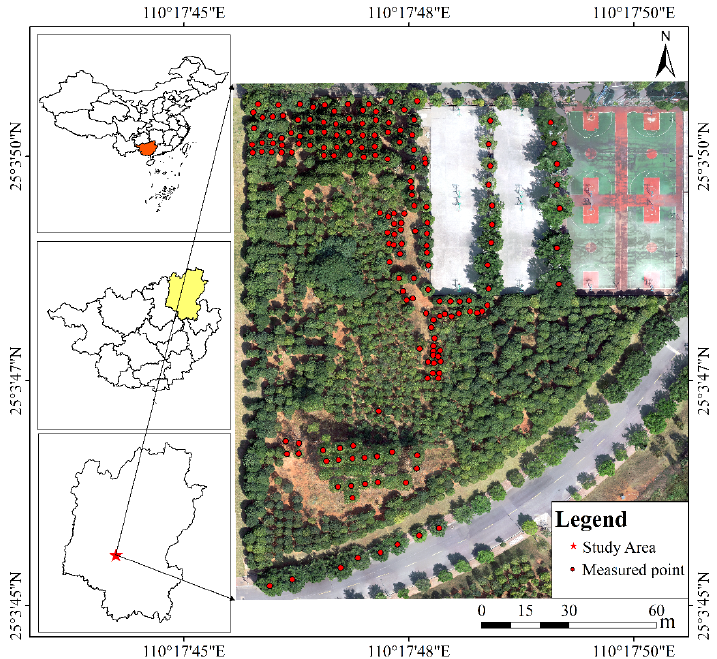
Figure 1. Spatial distribution map of the study area and sampling points.